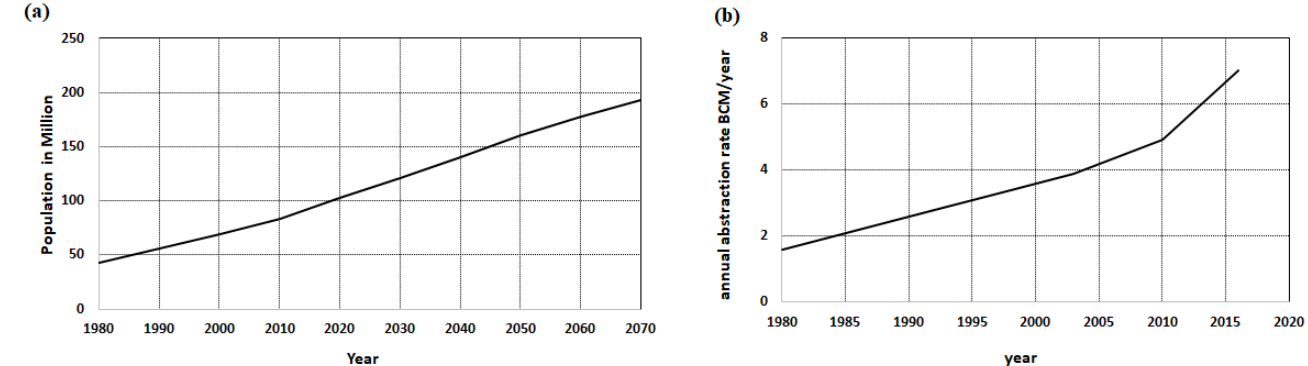
Figure 2. ( a ) Egyptian population growth [43] and ( b ) The annual abstraction rates in MNDA [44]. The NDA is recharged through the Nile River flow, percolation from excess irriga- tion, rainfall and seepage from canals. The significant source of GW recharge in the Nile Delta is the Nile River flow as the NDA receives around 35.5 km 3 /y from the Nile